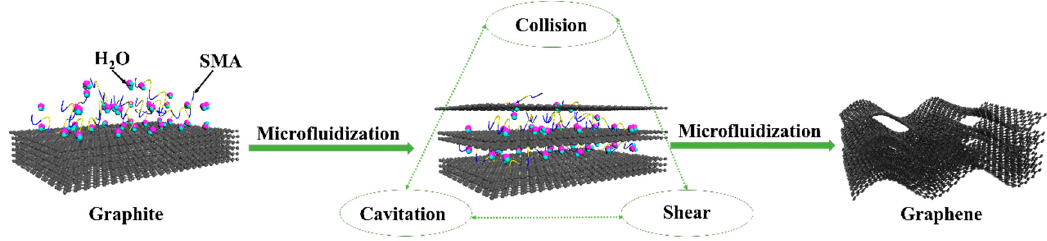
Figure 2. Scheme of the SMA-assisted liquid phase exfoliation method used to produce graphene from graphite.